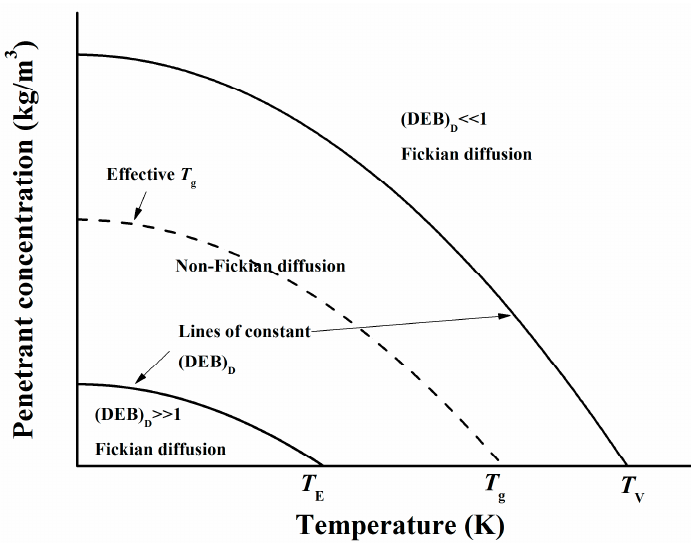
Figure 4. Schematic picture of the different zones of diffusion, separated by lines of constant diffusion Deborah number (DEB) D , as related to penetrant concentration and temperature [61].